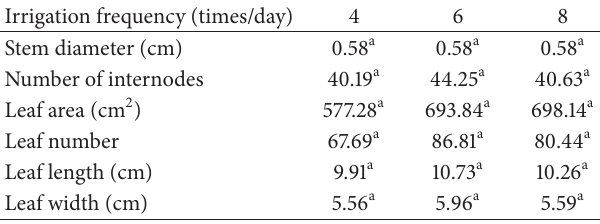
Figure 2: Interaction effects of irrigation frequencies and substrate volumes on water potential in leaves of chrysanthemum. Table 4: Effect of irrigation frequencies on shoot growth of chrysanthemum.